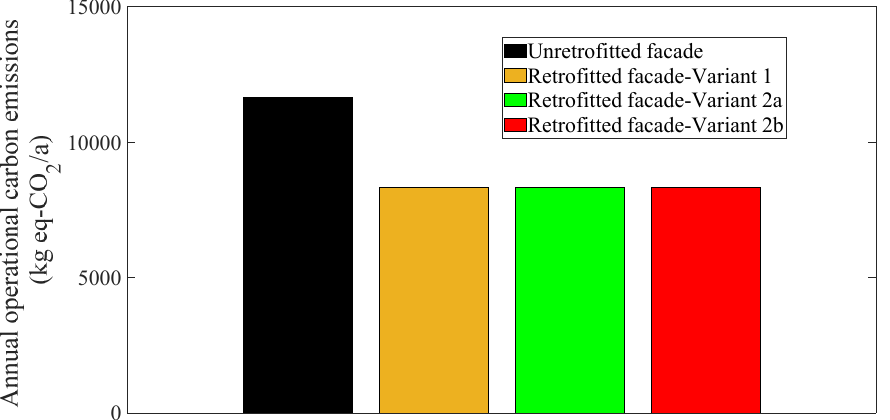
Figure 9. Comparison between the operational carbon emissions of the unretrofitted and the retrofitted building for the three retrofitting alternatives.